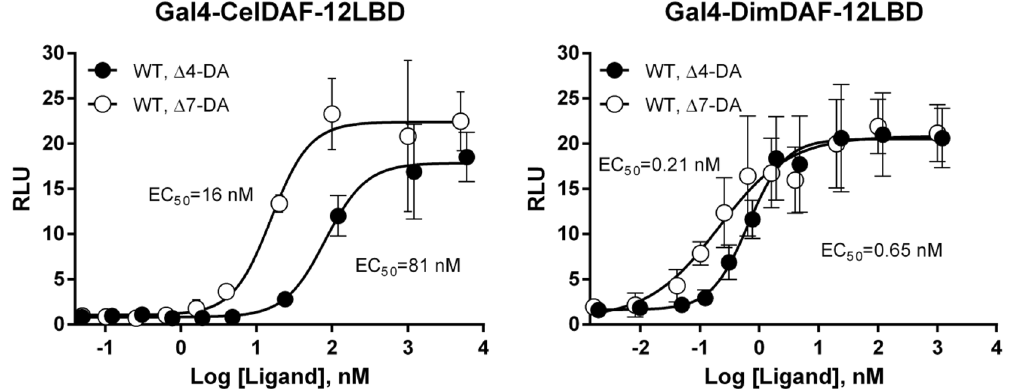
Figure 2. Dafachronic acids activate DimDAF-12 in a dose-dependent manner. NIH3T3 cells were co-transfected either with Gal4-CelDAF-12_LBD ( A ) as control or with the wild-type construct Gal4- DimDAF-12_LBD ( B ) and luciferase gene reporter construct. Recombinant cells were incubated with increasing concentrations of Δ4- or Δ7-DA (respectively up to 5 or 6 µM). The ligand binding and transactivation activity were assessed by measuring the luciferase activity, which was normalized by Renilla luciferase activity for transfection efficiency and expressed as relative light units (RLU). Data represent the average of normalized luciferase activity and the error bars correspond to the standard error of mean from quadruplate assays. The experiments were repeated at least two times in triplicate or quadruplate. The figure shows a representative experiment using Prism 6.0 (Graph Pad Software,